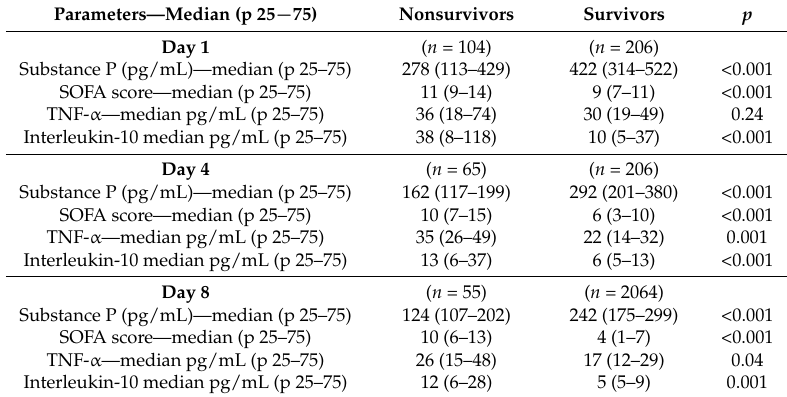
Table 2. Comparisons on evolution of serum levels of substance P, TNF- α and IL-10, and SOFA score during the first week of severe